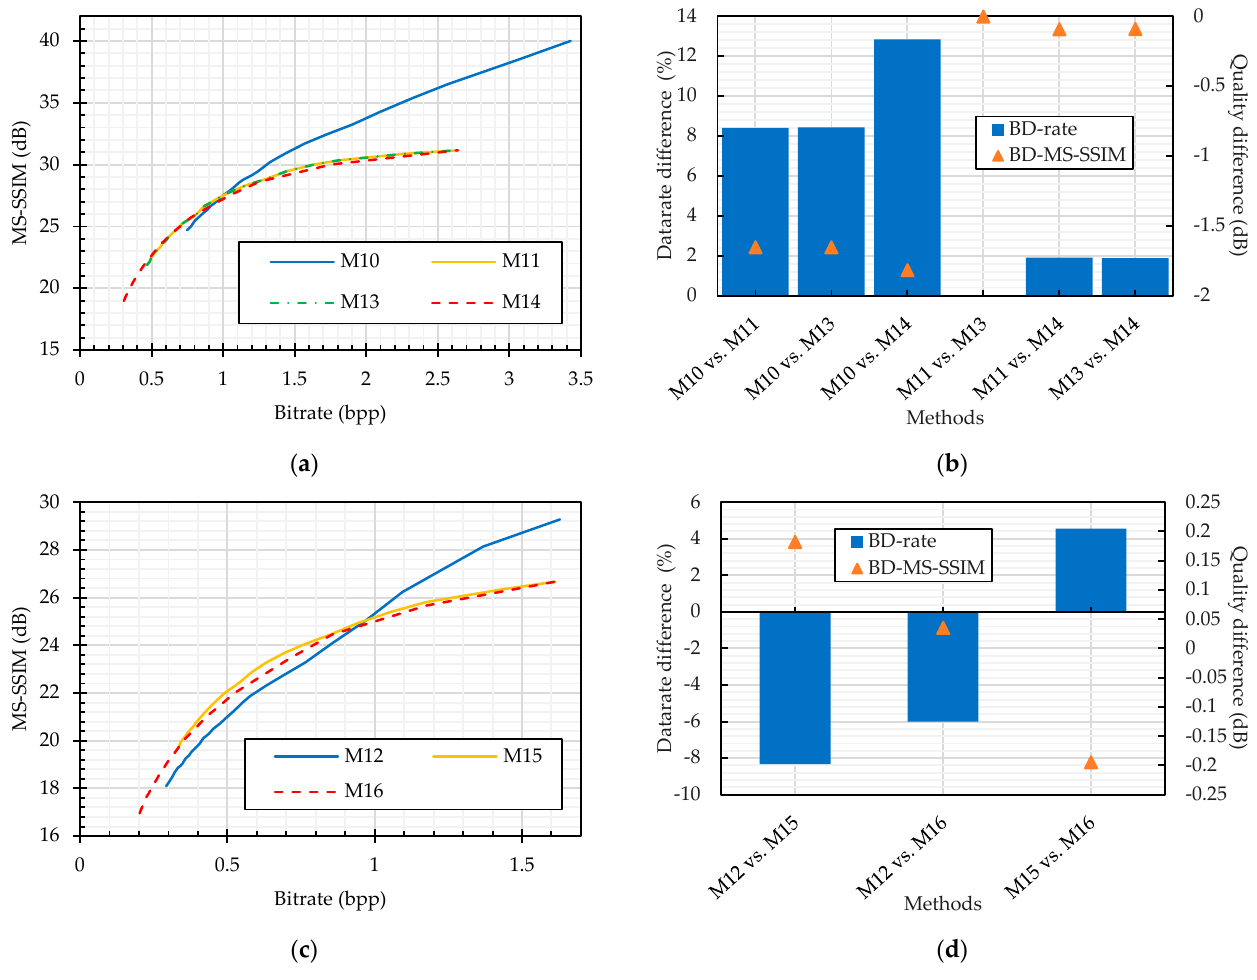
Figure 13. The JPEG compression analysis in color and grayscale mode. The JPEG compression is carried out without chroma subsampling in ( a ) and with chroma subsampling in ( c ); ( b , d ) are their corresponding BD-measures plots.